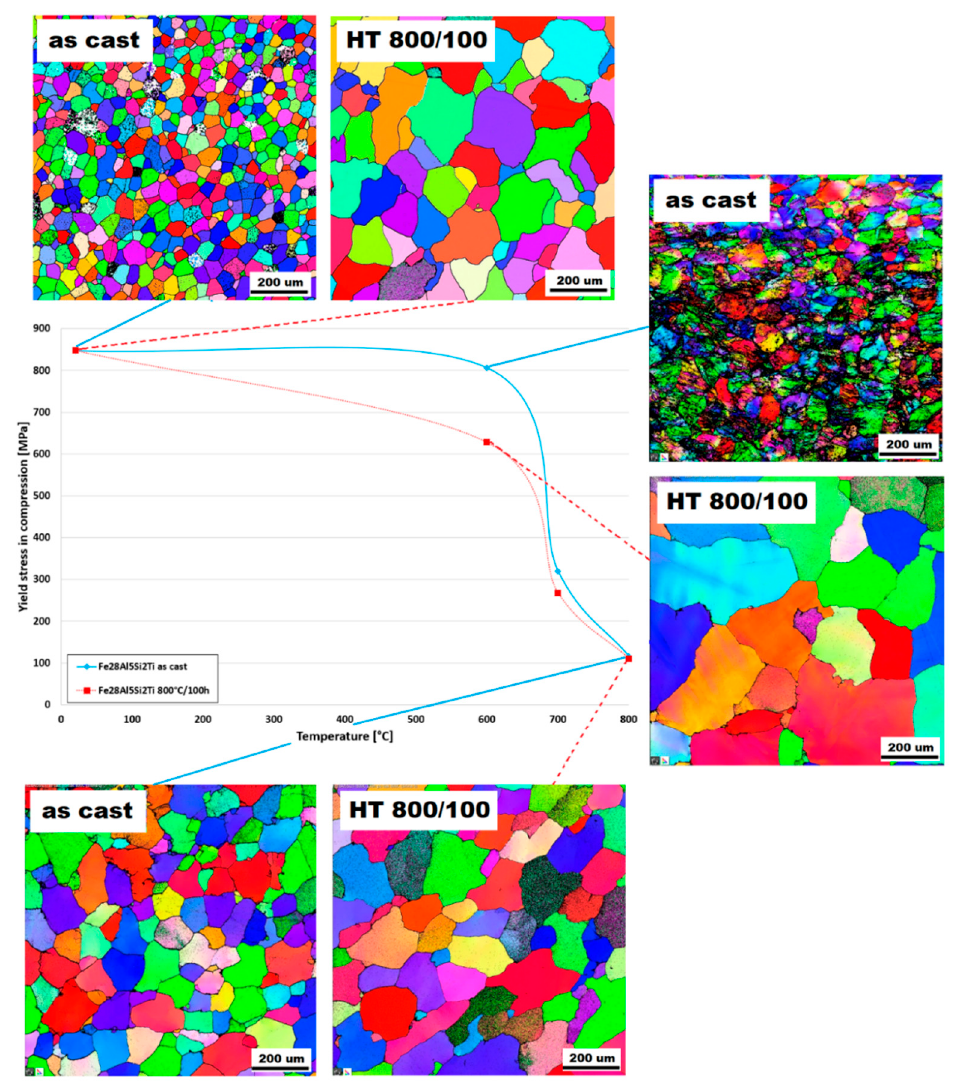
Figure 7. The comparison of grain size of Fe28Al5Si2Ti alloy after performed compression tests (the solid line corresponds to the as-cast state, the dashed line to the annealed state) .